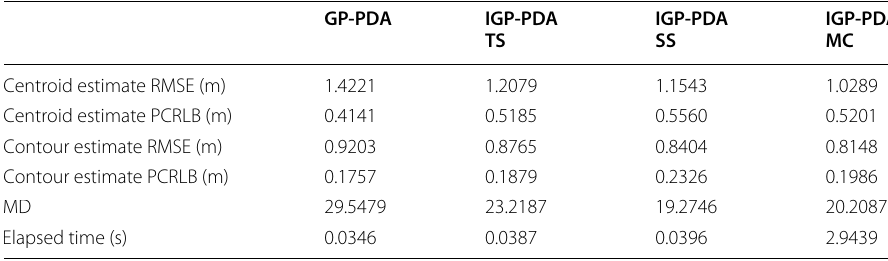
Table 1 Performance of different models in the first scenario